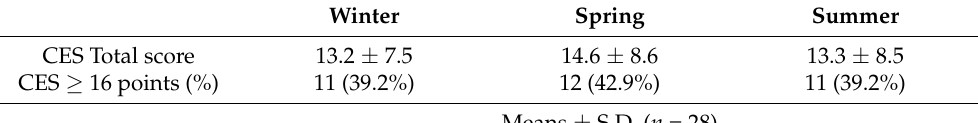
Table 5. Seasonal changes in the total CES-D score and percentage of subjects with CES ≥ 16 points. Winter